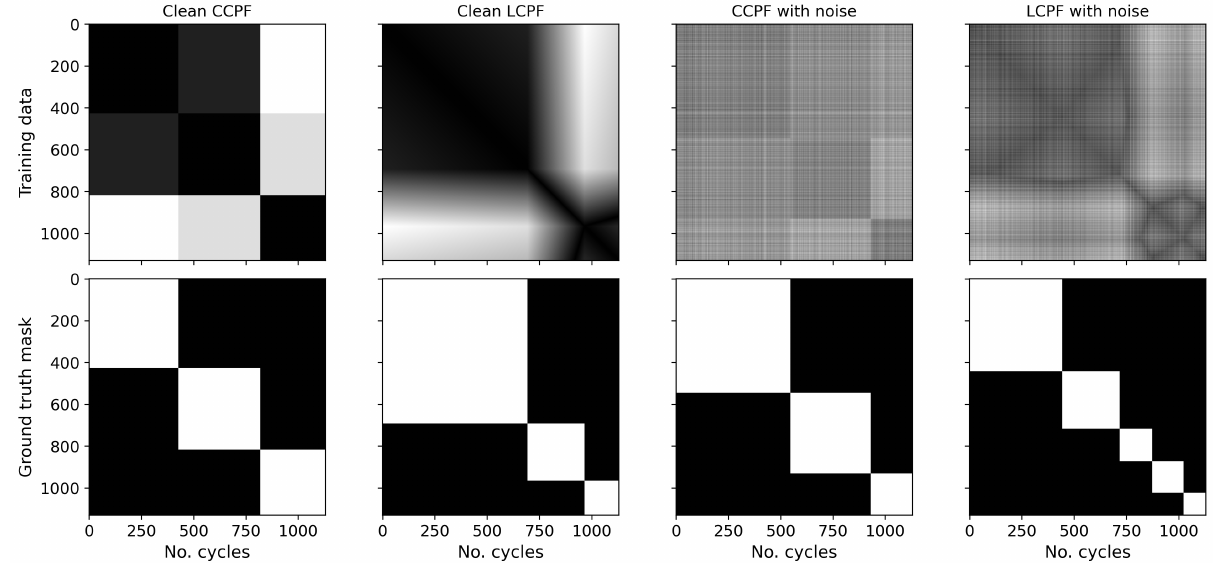
Figure 2. Distance matrices represented as images with several configurations, used for U-NET training with their associated ground truth.